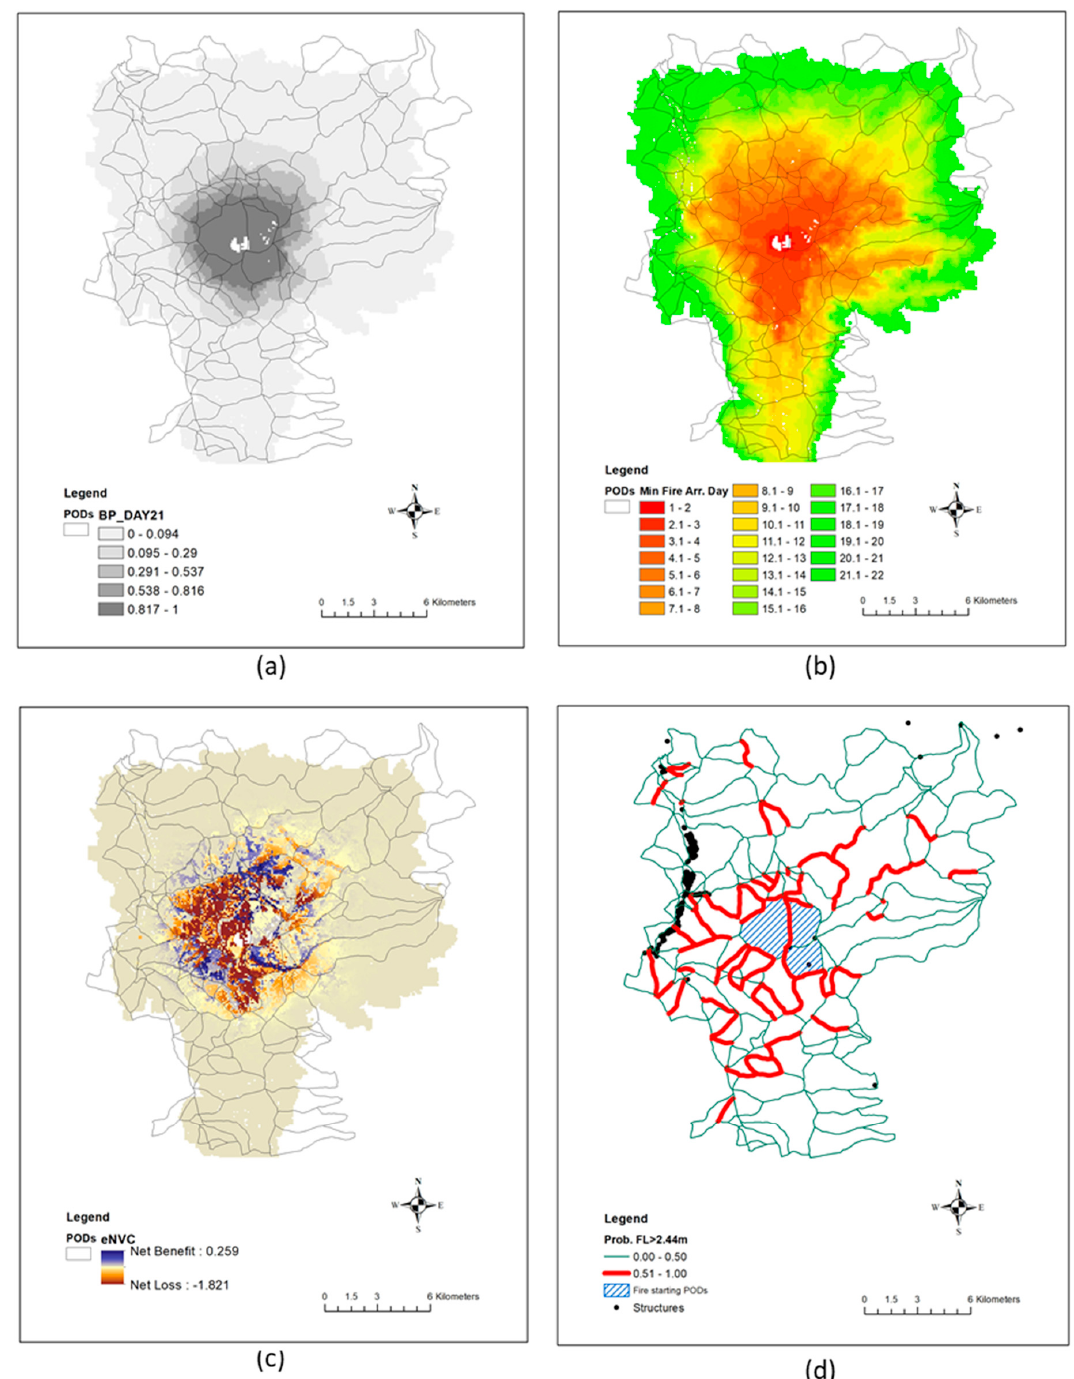
Figure 3. Simulated fire behavior metrics from FSPro and Flep-Gen. Panel ( a ) displays burn probabilities for each pixel, over a 21-day horizon; panel ( b ) displays the minimum fire arrival day for each pixel; panel ( c ) displays expected net value change for each pixel; panel ( d ) displays the structures that may need point protection and the POD boundaries with more than 50% of chance of having an average flame length greater than 2.44 m (8 ft). These boundaries are considered as higher risk lines (HRLs) from the fire fighter safety aspect.